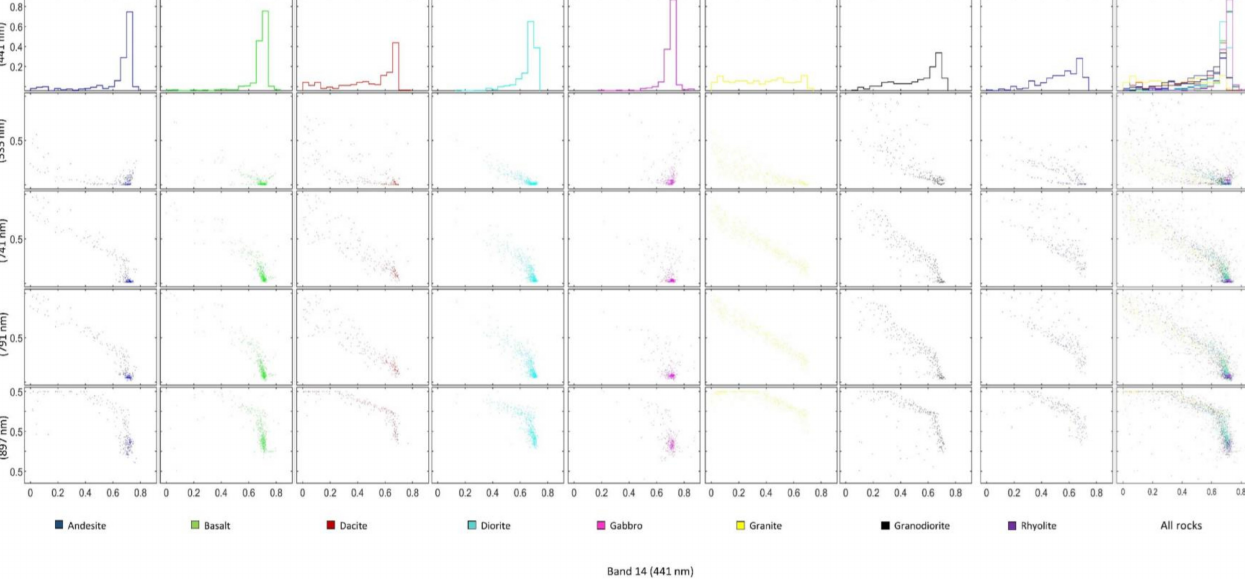
Figure A2. Relative scatter and histogram plots of rock spectral reflectance strengths in 2D plane projections, where bands 441 nm is the x-axis, and bands 535 nm, 741 nm, 791 nm and 897 nm are the y-axis. The position of each point (spectra) is based on the relative intensities between bands, as well as between